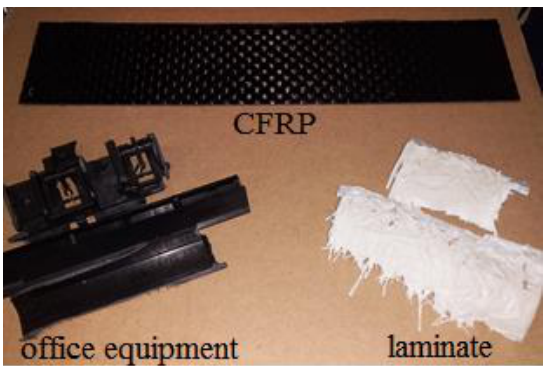
Figure 1. PCM waste under study: CFRP – scraps of aviation carbon fiber reinforced plastic, office equipment – heat-resistant PET-GF composite printer parts, laminate - composite for bath reinforcement: fiberglass + micro calcite + epoxy resin